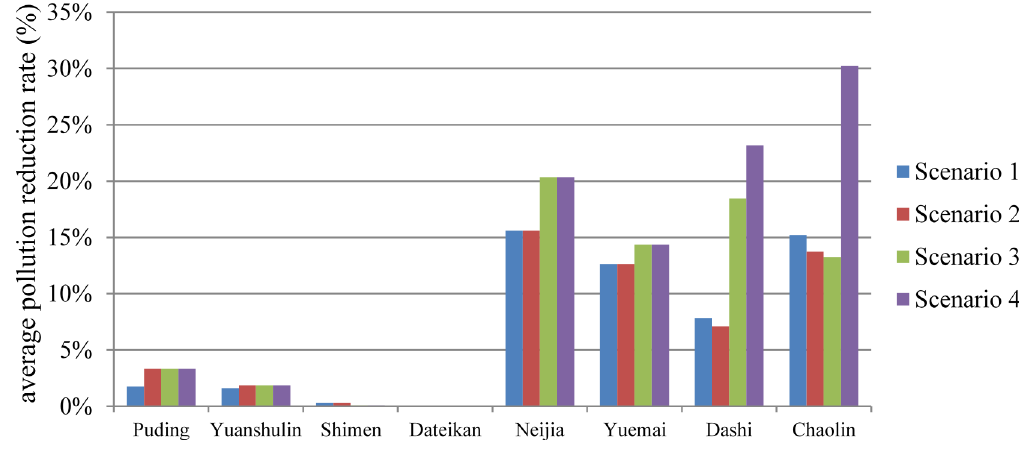
Figure 8. Pollution reduction for four LID scenarios for different sewage collection